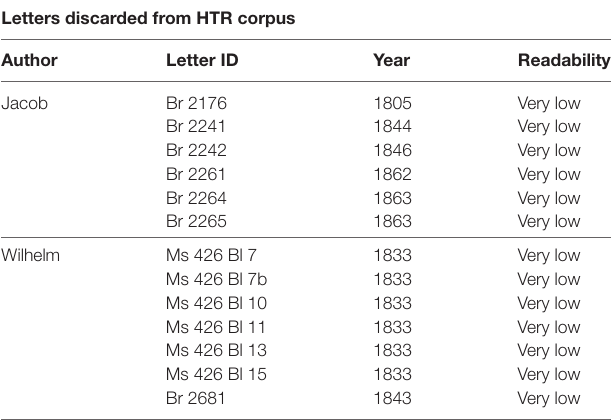
Table 3 | Letters discarded from the HTR training corpus due to their very poor readability, which negatively affected the first HTR